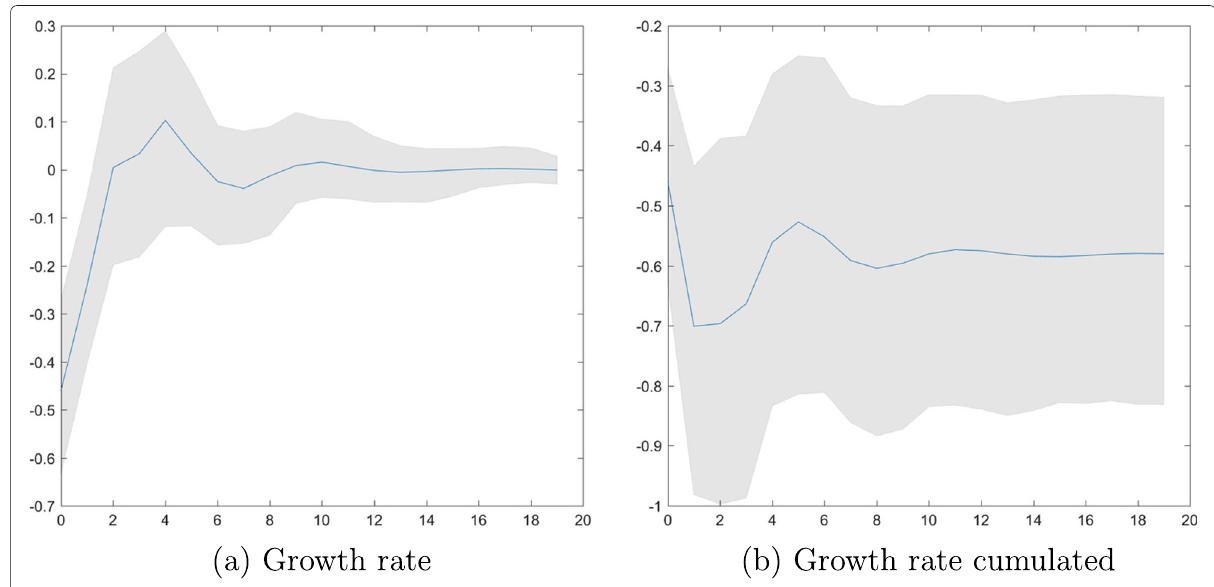
Fig. 8 GDP growth. Impulse responses to a shock corresponding to an unexpected doubling of log short-time workers